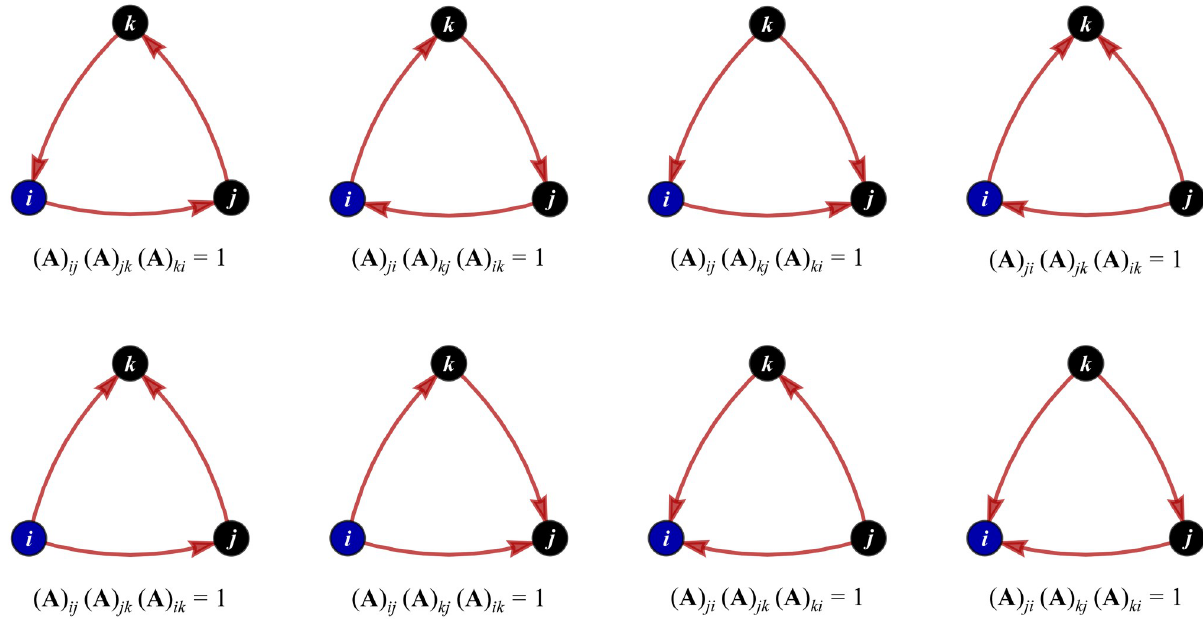
Fig 1. Eight different triangles containing node i in a directed network. The product of the form ( A ) �� ( A ) �� ( A ) �� = 1 below each triangle indicates its existence in the network.